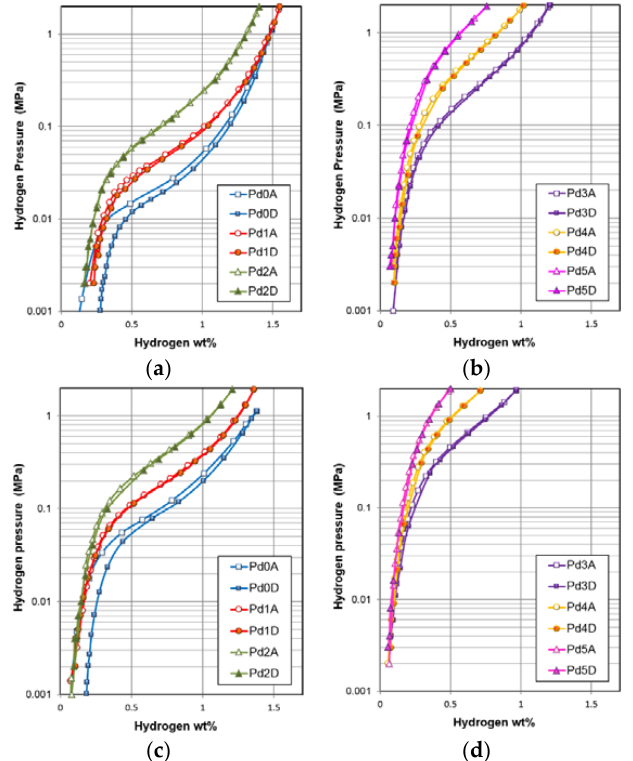
Figure 10. 30 °C PCT isotherms of alloys ( a ) Pd0, Pd1, and Pd2 and ( b ) Pd3, Pd4, and Pd5 and 60 °C PCT isotherms of alloys ( c ) Pd0, Pd1, and Pd2 and ( d ) Pd3, Pd4, and Pd5. Open and solid symbols are for absorption and desorption curves, respectively.